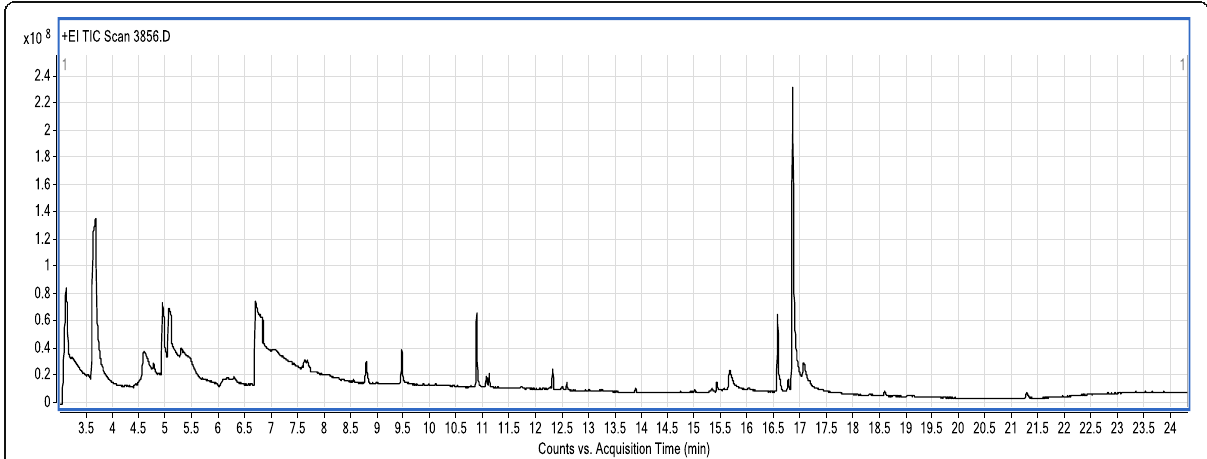
Fig. 3 Compounds concentration peak areas which were extracted from Spirulina platensis